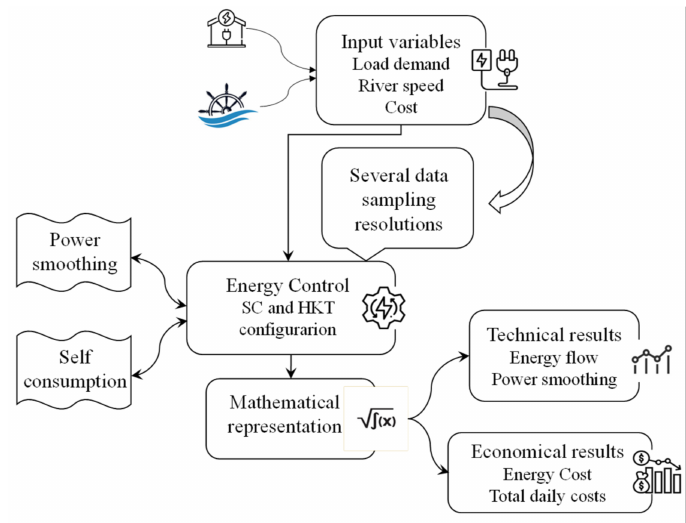
Figure 1. Representative diagram of the proposed methodology.